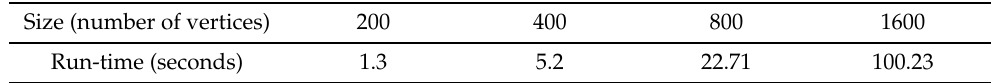
Table 3. AC algorithm run-time